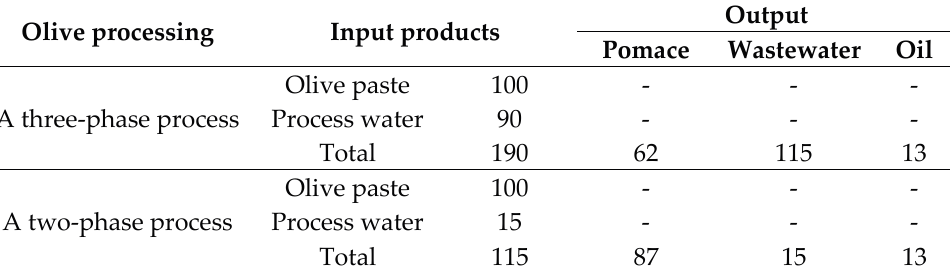
Table 1. The input-output mass balance (kg) of the olive oil